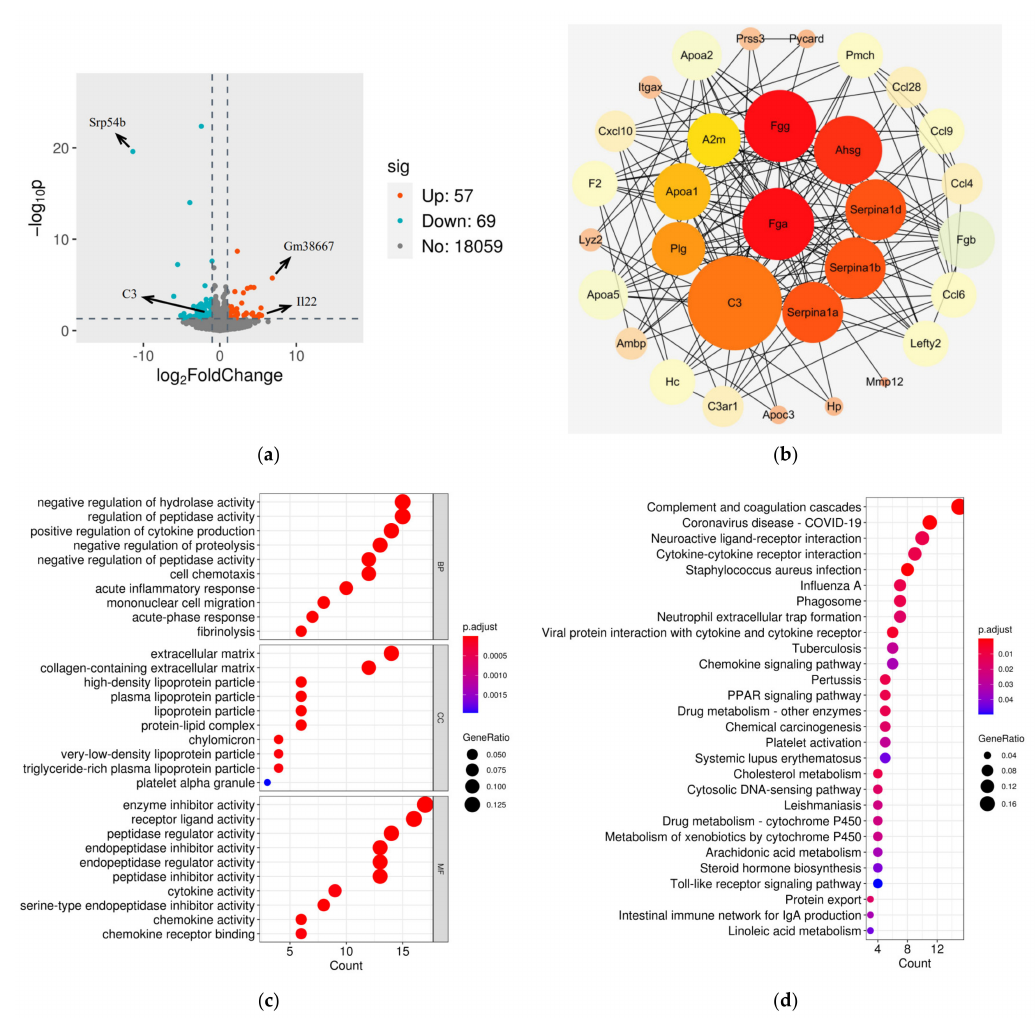
Figure 3. Comparison of mRNA expression profiles between two groups. ( a ) Volcano plot of mRNA expression data. Blue and red dots represent differentially expressed genes (DEGs) filtered based on cutoff values |log 2 FoldChange| ≥ 1 and p < 0.05. Grey dots represent genes with no significant differential expression; ( b ) Protein–protein interaction (PPI) network of DEGs. Circles represent genes and black lines represent interaction partners of the DEGs. Each circle is color-coded according to score using the maximal clique centrality (MCC) method. The larger red and orange circles show the hub genes. ( c ) Dot plot of the most significantly enriched Gene Ontology (GO) (BP: biological process, CC: cellular component, MF: molecular function) terms. Each dot is color-coded according to the adjusted p value. Dot size corresponds to gene count; ( d ) Dot plot of all significantly enriched Kyoto Encyclopedia of Genes and Genomes (KEGG)